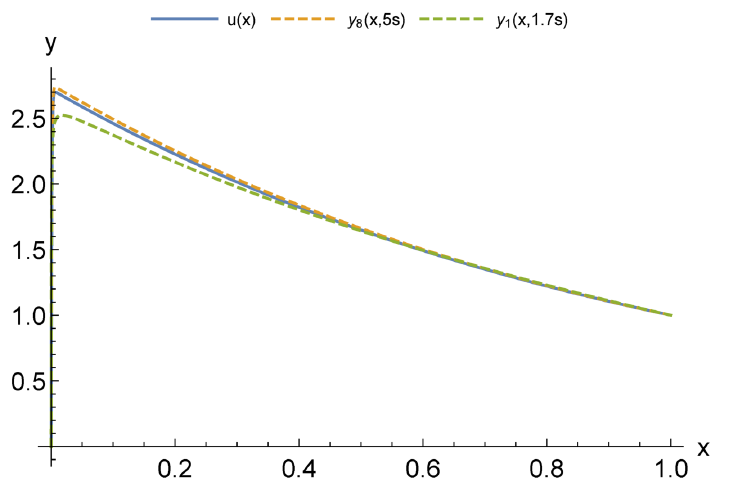
Figure 17. Plots of multilayer parametric solutions y 8 ( x ,5 s ) , y 1 ( x ,1.7 s ) with optimal initial points, as applied to problem (30), and its exact solution u ( x ) (parameter value s = 0.001), corresponding to dashed lines and solid line,